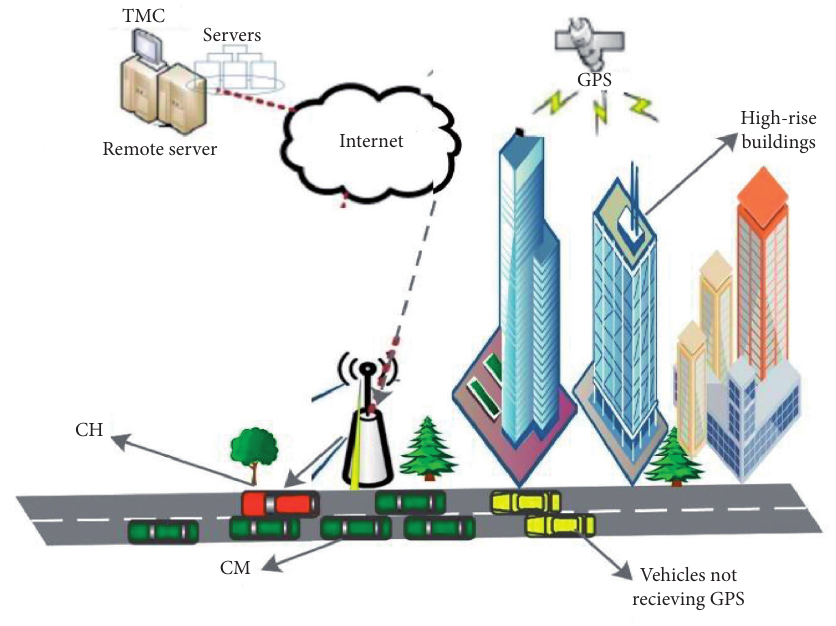
Figure 1: Urbane VANET